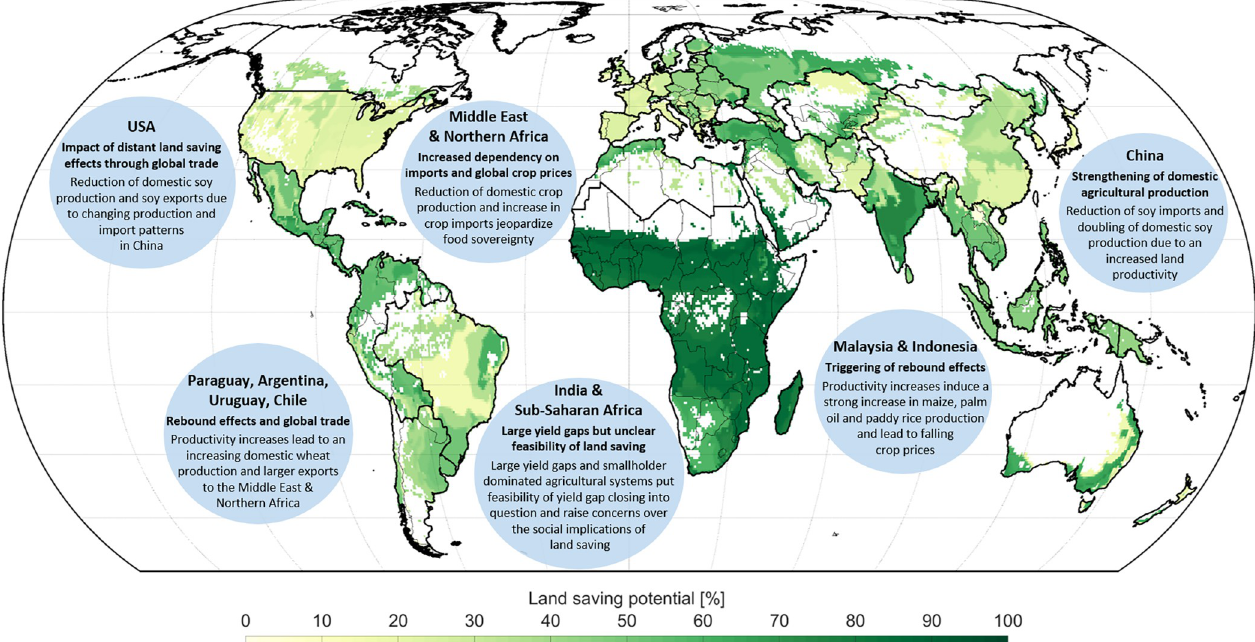
Fig 6. Graphical summary of identified regional effects and implications of land saving. Different identified effects are displayed exemplarily for the most dynamic regions. The underlying global map shows the biophysical land saving potential (BLS) in percentage of total cropland (summed up over all considered crops according to Monfreda et al. [115], see S2 Appendix) for each sub-region. As land saving can only be implemented on current cropland areas, land that is currently not used as cropland is masked out. The thick region lines show the aggregated 17 study regions (see S3 Appendix), while the country boarders are displayed according to the global administrative areas of GADM version 2.8. Reprinted from GADM (https://gadm.org/) under a CC BY license, with permission from GADM, original copyright 2012.